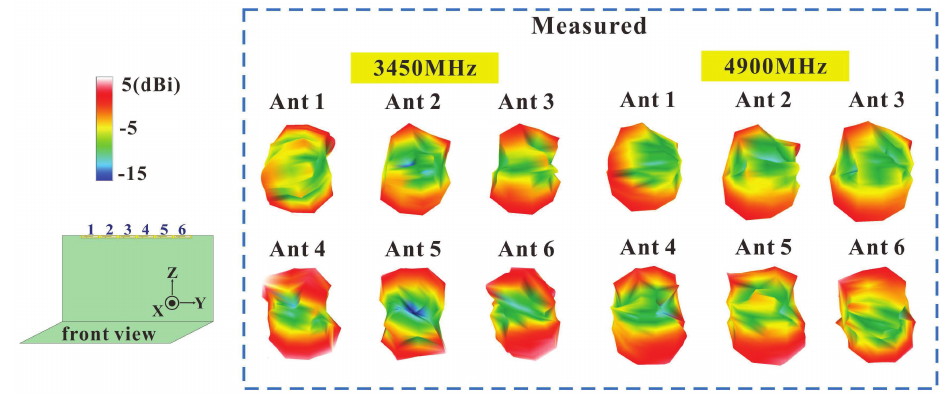
Figure 9. Measured 3D radiation patterns for six antennas at 3450 MHz and 4900